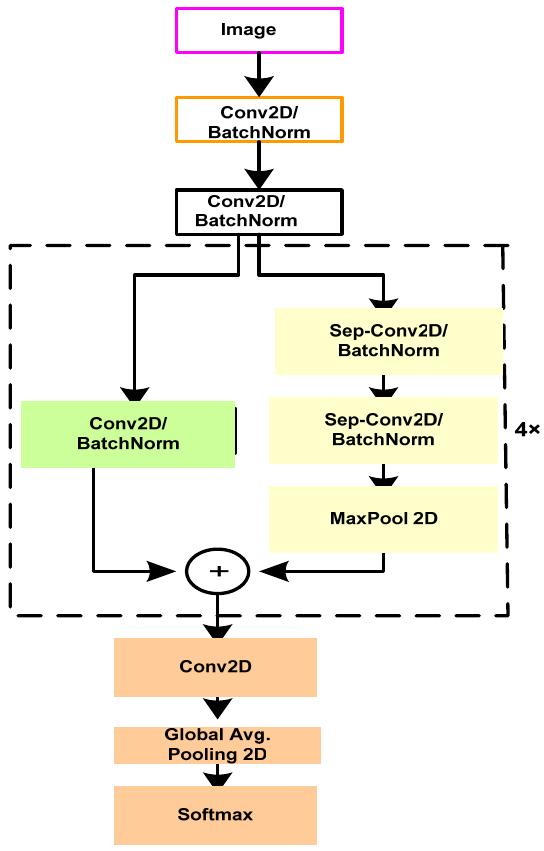
Figure 10. Mini_Xception model architecture. Table 2. Various Models tested on FER 2013